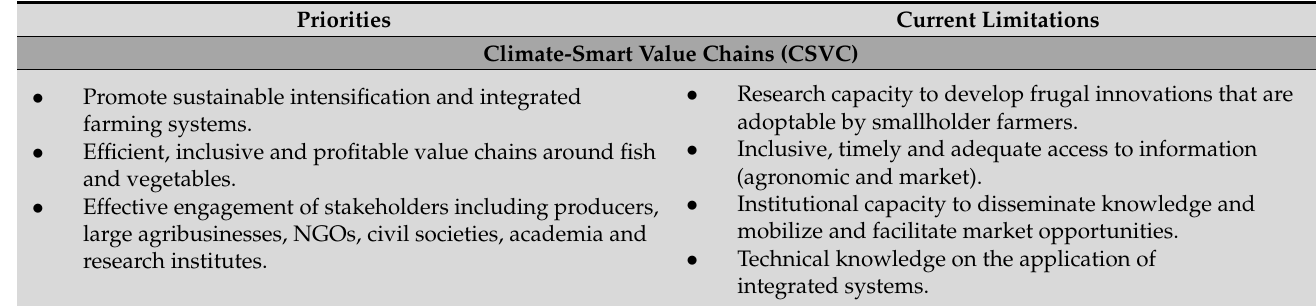
Table A1. Thematic areas, priorities, and existing limitations identified for each